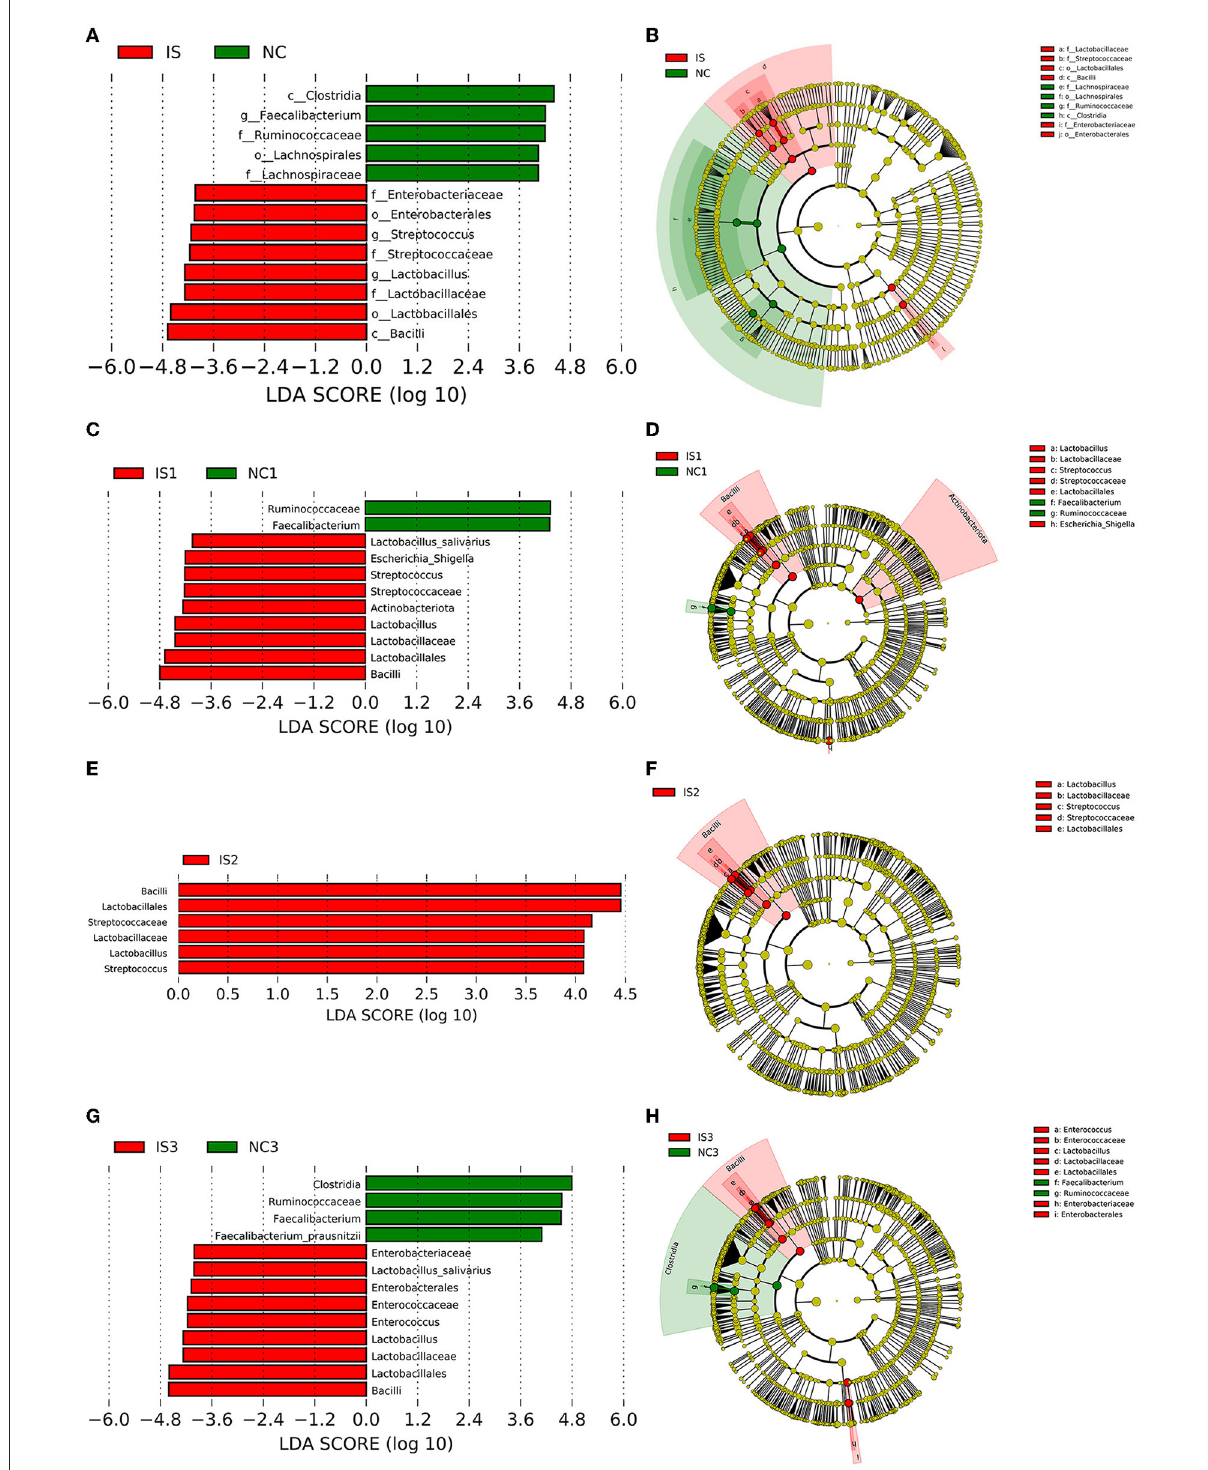
FIGURE2 The differences of gut microbiota between normal controls (NCs) and ischemic stroke (IS) patients in the entire population and for each ethnic people(Tujia, Miao, and Han). The IS patients of the Tujia, Miao, and Han people were indicated with IS1, IS2, and IS3, respectively. The NCs of the Tujia, Miao, and Han people were indicated with NC1, NC2, and NC3, respectively. (A–H) Histograms of the LDA scores for the bacterial taxa differentially abundant between NCs (green bars) and IS patients (red bars) (LDA score > 4.0, P < 0.05), and cladograms generated by LEfSe indicating differences in the bacterial taxa between NCs (green dots) and IS patients (red dots) in the entire population and for each ethnic people(Tujia, Miao, and